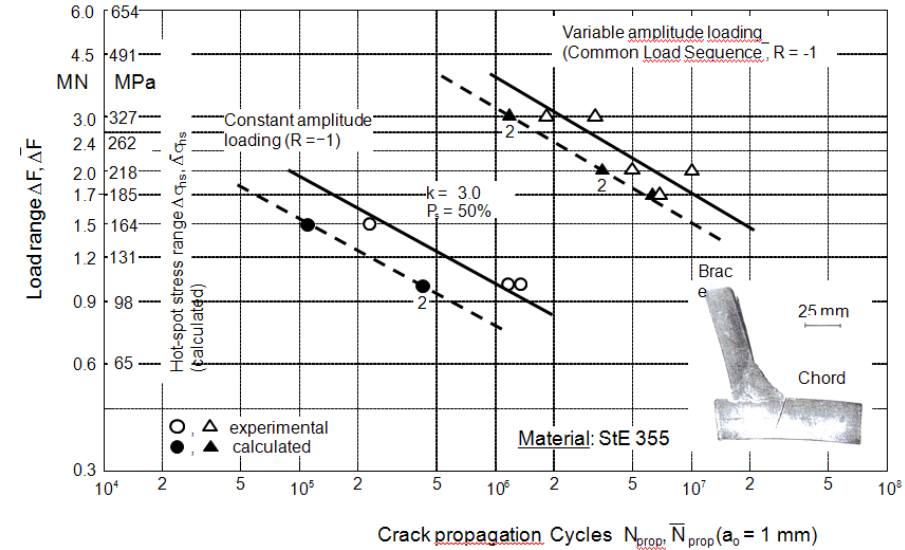
Figure 16: Comparison of experimental and calculated crack propagation